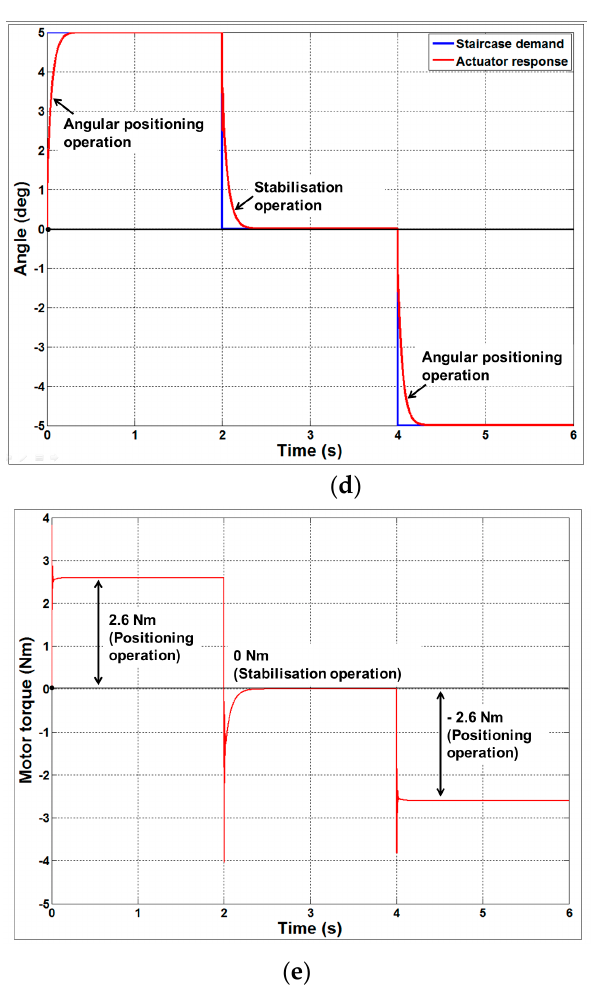
Figure 9. Staircase input response of the actuator. ( a ) Steady-state and dynamic characteristics of the actuator for a staircase input; ( b ) Speed characteristics of the actuator for a staircase input; ( c ) Actuator speed with respect to missile fin angle for a staircase input; ( d ) Angle response of the actuator for a staircase input; ( e ) Torque characteristics of the actuator for a staircase input.